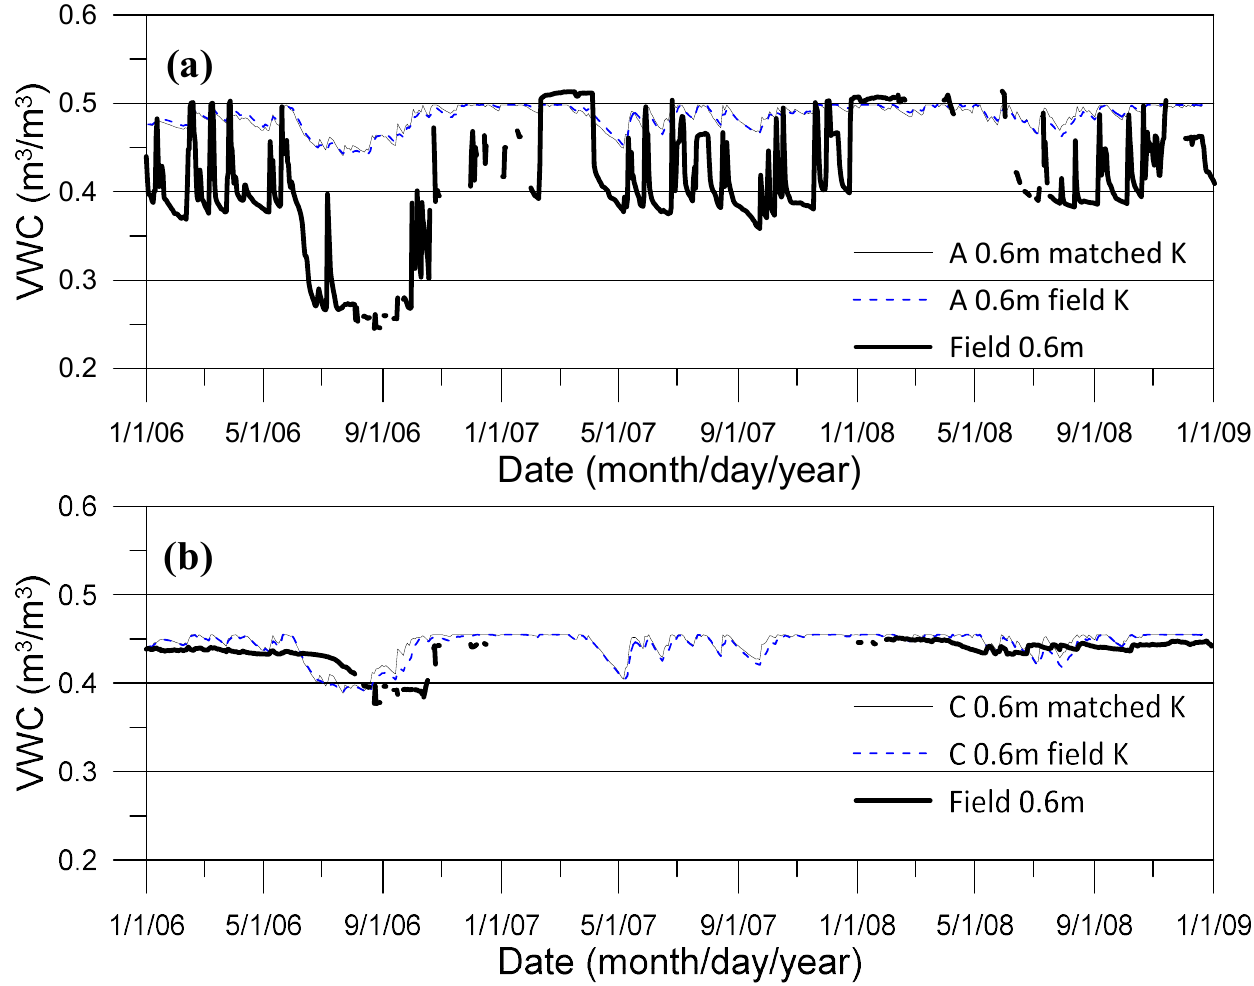
Figure 13. Measured and calculated volumetric water content 0.6 m depth ( a ) at location A and ( b ) at location C.